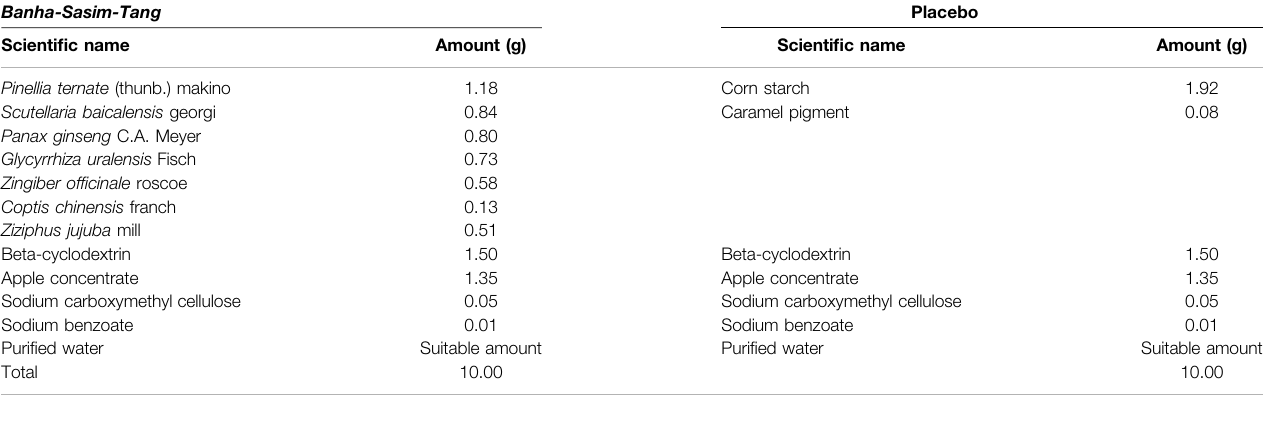
TABLE 2 | Components of Banha-Sasim-Tang and Placebo in one syrup.